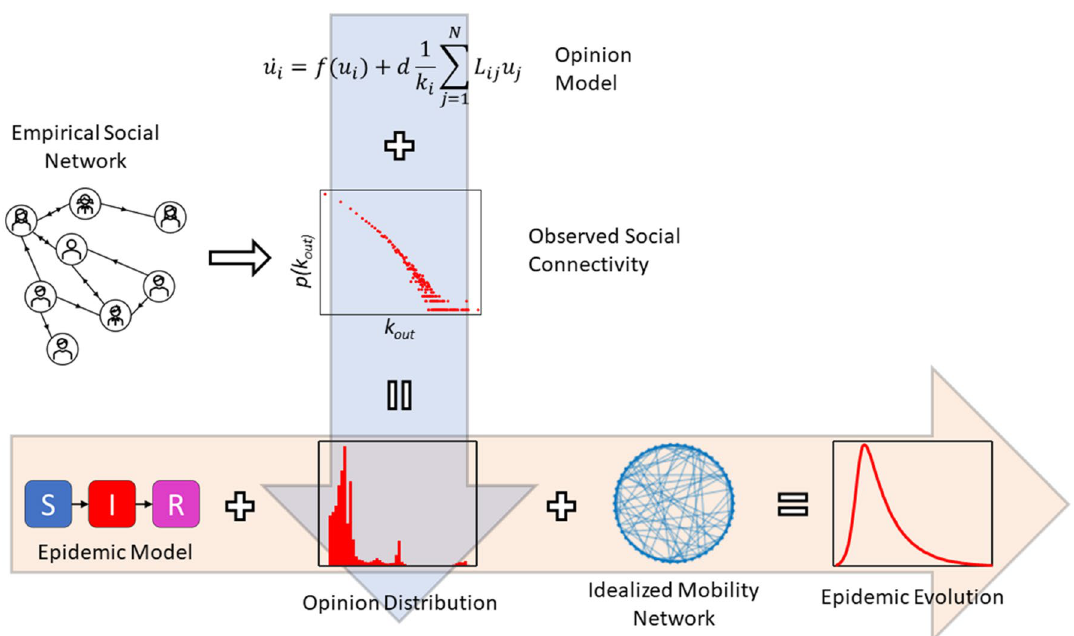
Figure 4. Workflow of the simulations. The empirical social network is obtained from microblogging. This network is introduced in an opinion model (blue arrow) that provides an opinion distribution function statistically describing the eagerness of the population to follow new government policies (social distance policies). The last step (orange arrow) incorporates this opinion model as modulation of the infection rate in an epidemic